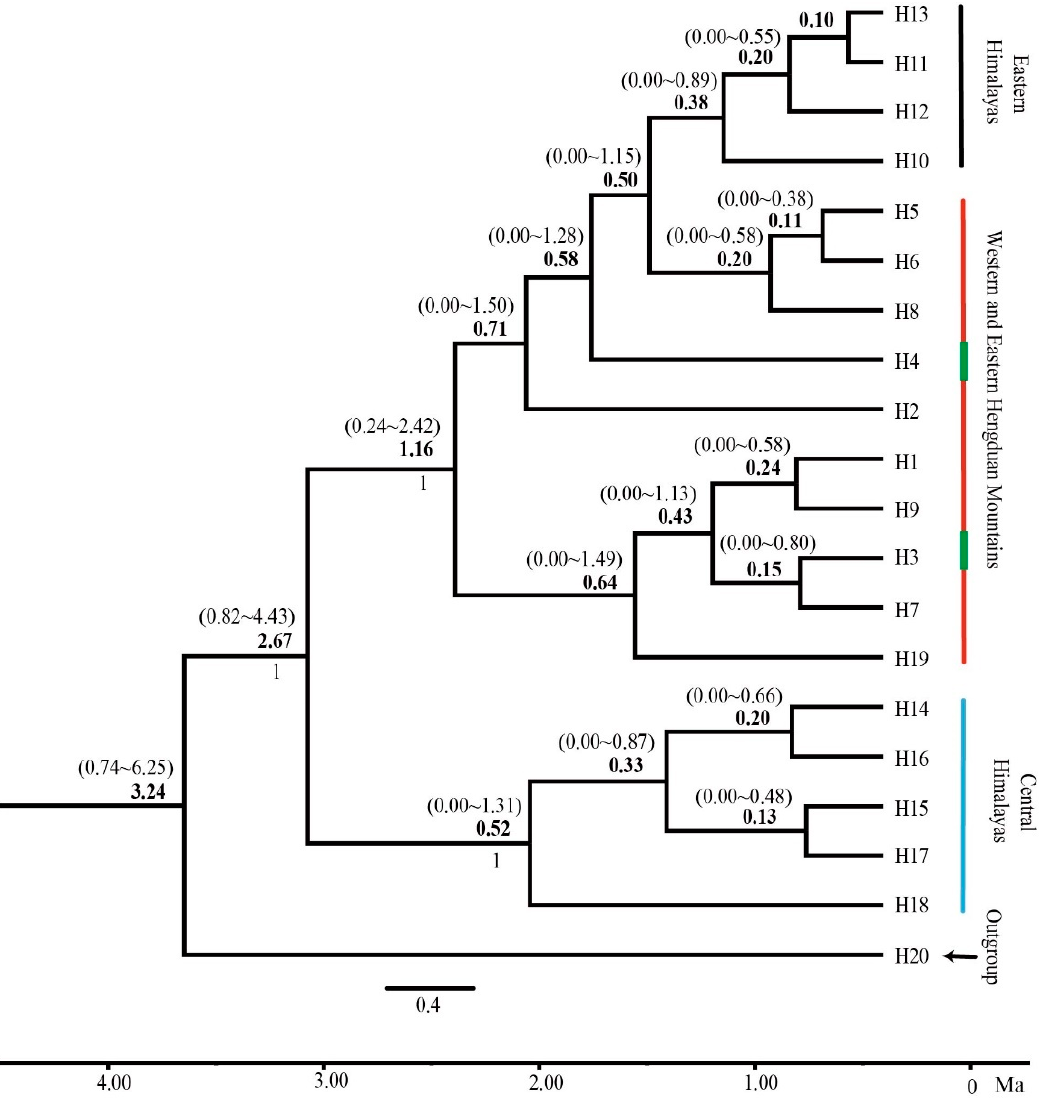
Figure 5. Divergence time estimation among populations of Gaultheria nummularioides . The majority-rule chronogram generated from divergence time analysis of 19 haplotypes in G. nummularioides . Divergence times estimates are in boldface and their 95% HPD values are in parentheses above the branches.